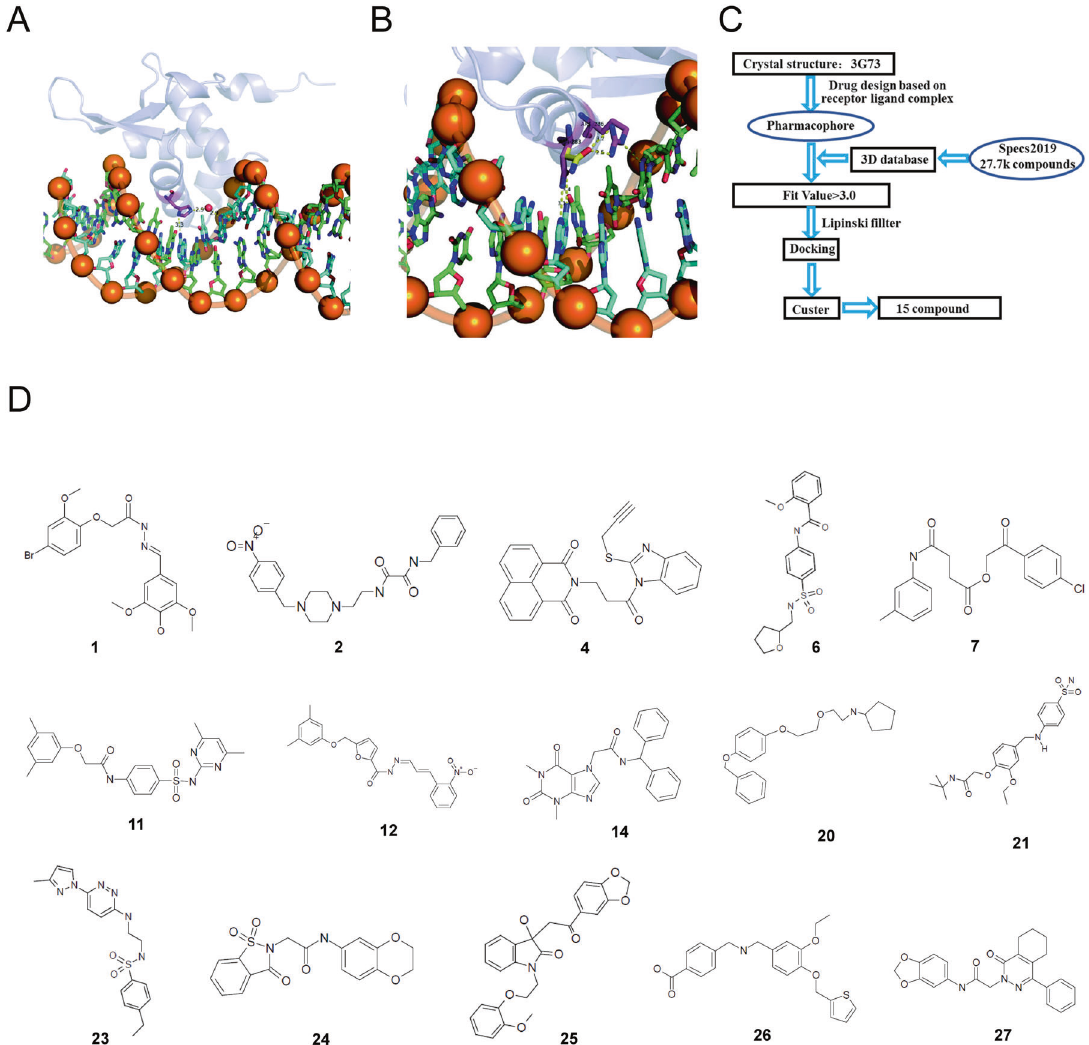
Fig. 1 Conserved residues analysis of FOXM1 DNA binding domain and screen small molecules selectively targeting FOXM1 DBD. A Shows the hydrogen bonding interactions of H287 with the DNA bases. The sidechain of H287 interacted with the DNA base via a direct H-bond and an indirect H-bond mediated by a water molecule. B Shows the interactions of N283 and R286 with DNA. The sidechain of N283 adopted two different conformations. With the vertical conformation (purple), the acid amide group of N283 formed two H-bonds with DNA. In contrast, with the horizontal conformation (yellow), N283 made little interaction with DNA but two H-bonds with the guanidine group of R286. As for R286, it contributed one H-bond with DNA. C The analysis steps were performed to select the fi nal 15 candidates from the space compound library. D Chemical structures of the 15